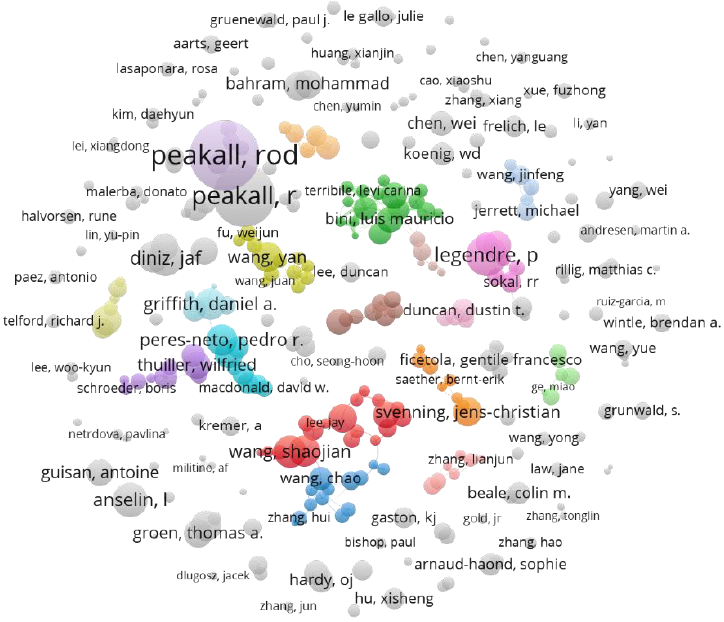
Figure 3. Co-author networks of SA research. (The colored groups are detected SA research com- munities. The size of the node is weighted by normalized citations which can highlight the leading scholar(s) (i.e., the node(s) with bigger size(s)) of each community.)